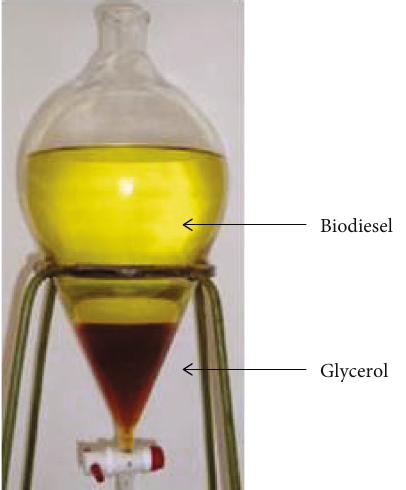
Figure 2: Separation of transesteri fi cation products [75].